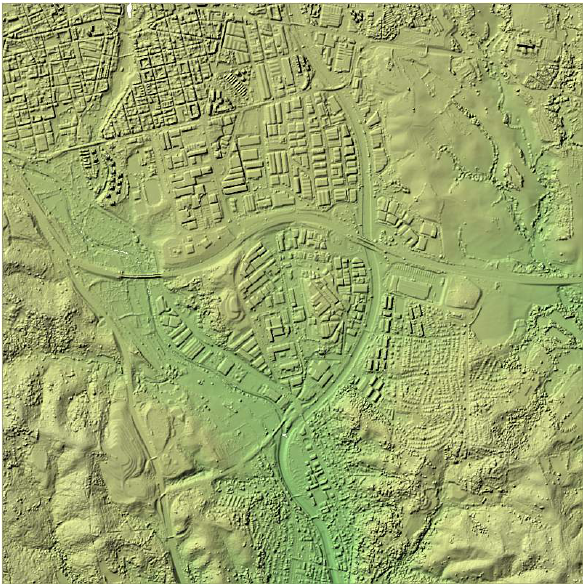
Figure 2: Shaded reference LIDAR DSM of the Terrassa